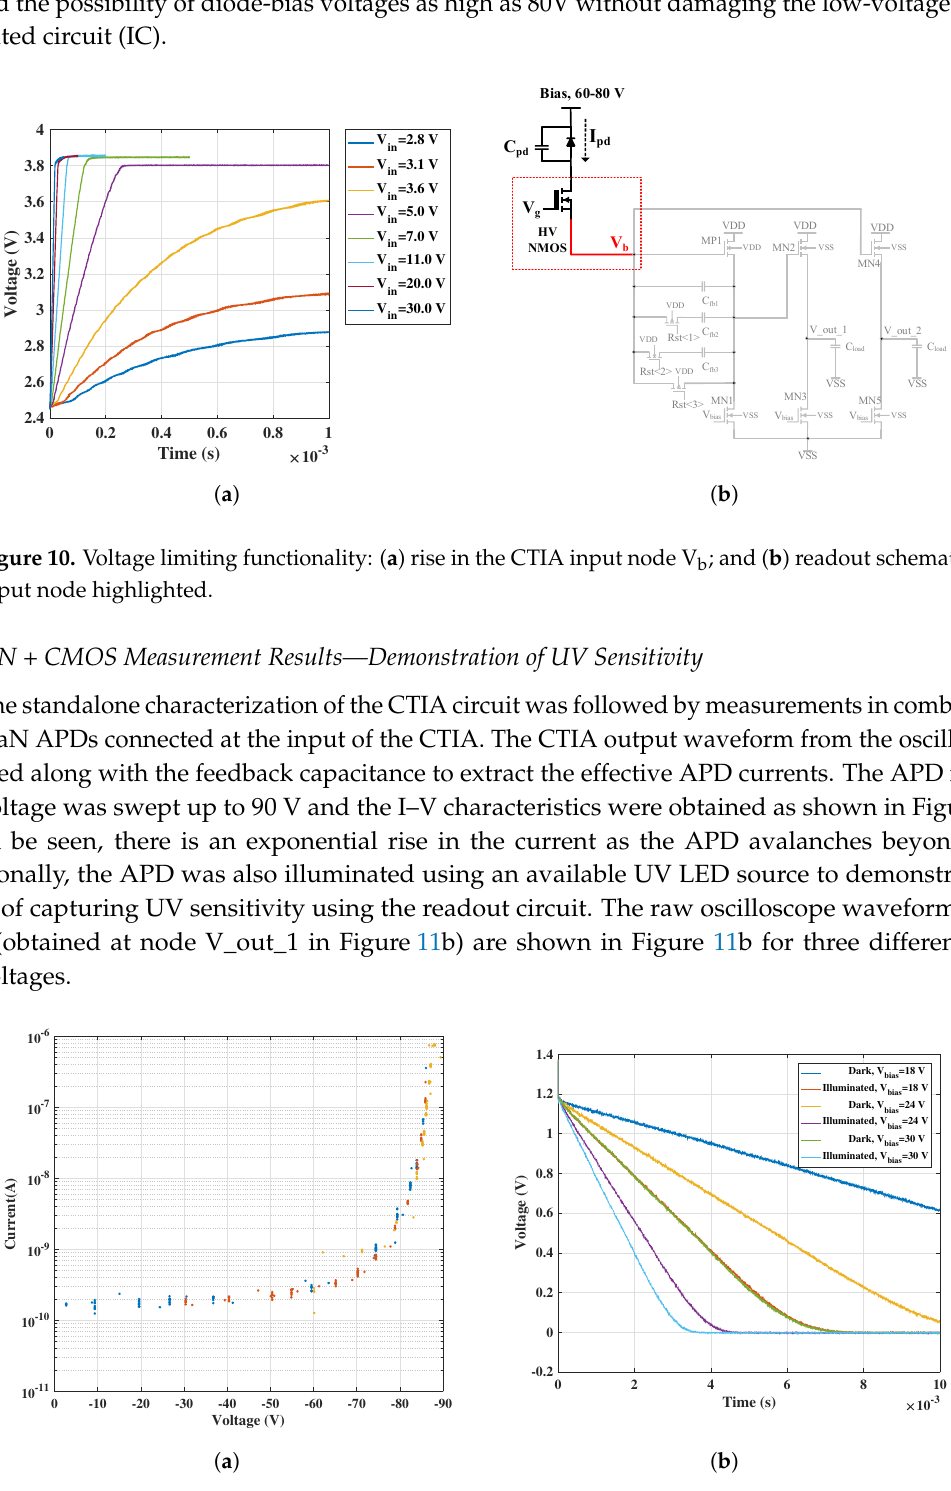
Figure 11. Characteristics of GaN sensor obtained using the CMOS readout circuit: ( a ) extracted I–V curve of a GaN APD; and ( b ) CTIA oscilloscope